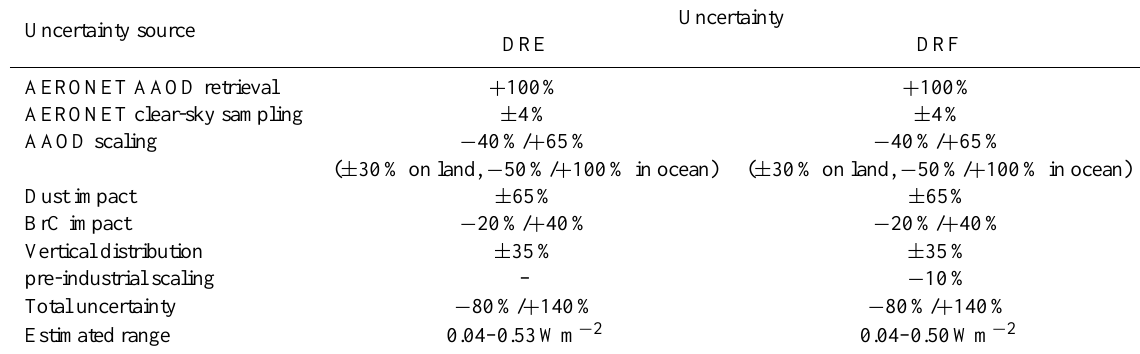
Uncertainty DRE DRF